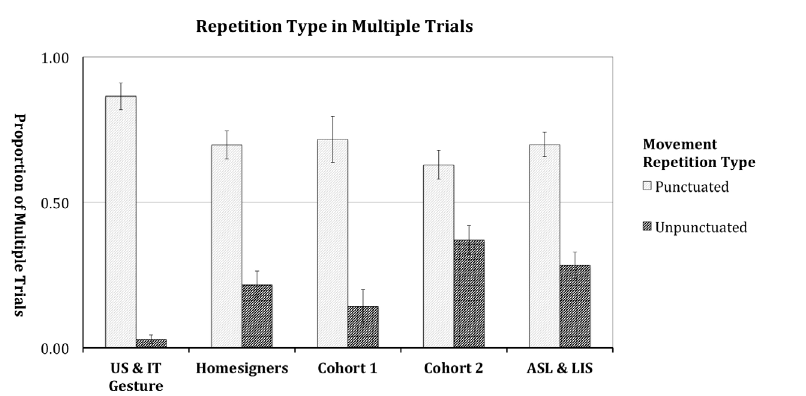
Fig. 7. The proportion of responses containing movements with repetition classified according to manner––punctuated (light gray bars) vs. unpunctuated repetition (dark gray bars)––produced by Silent Gesturers, Homesigners, NSL Cohort 1 signers, NSL Cohort 2 signers, and ASL/ LIS signers in response to all Plural vignettes. Error bars indicate standard errors.